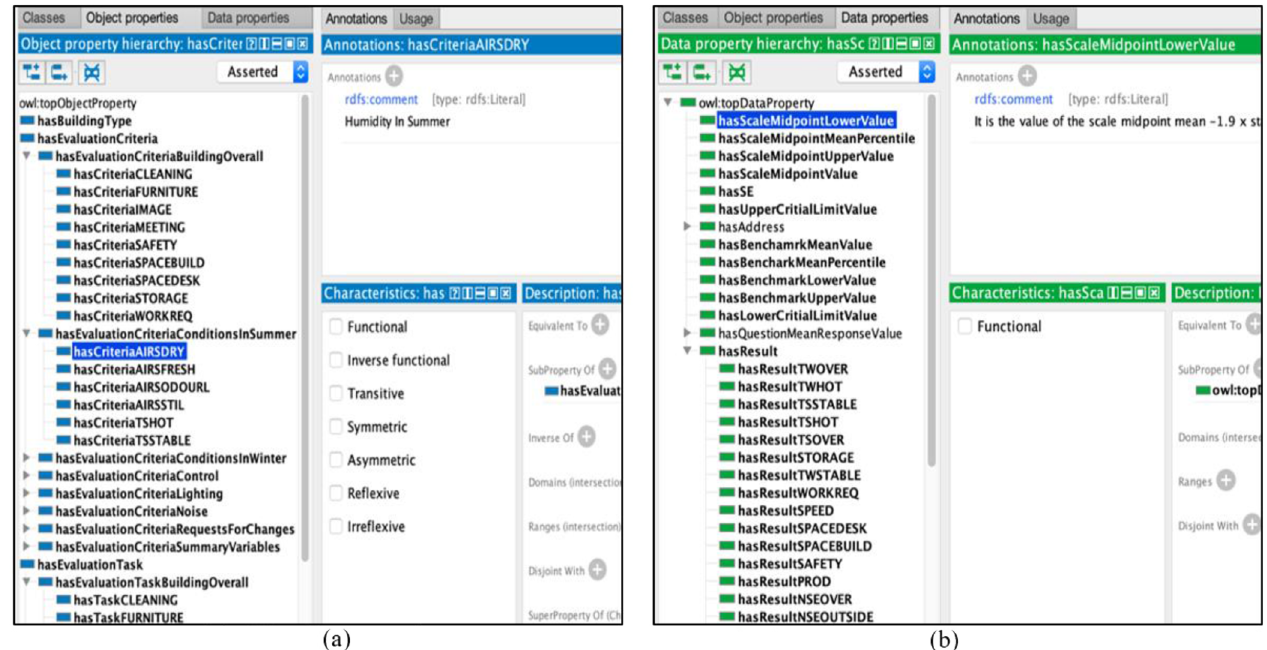
Fig. 4. Object property and data property in the proposed ontology. (a) objective property. (b) data